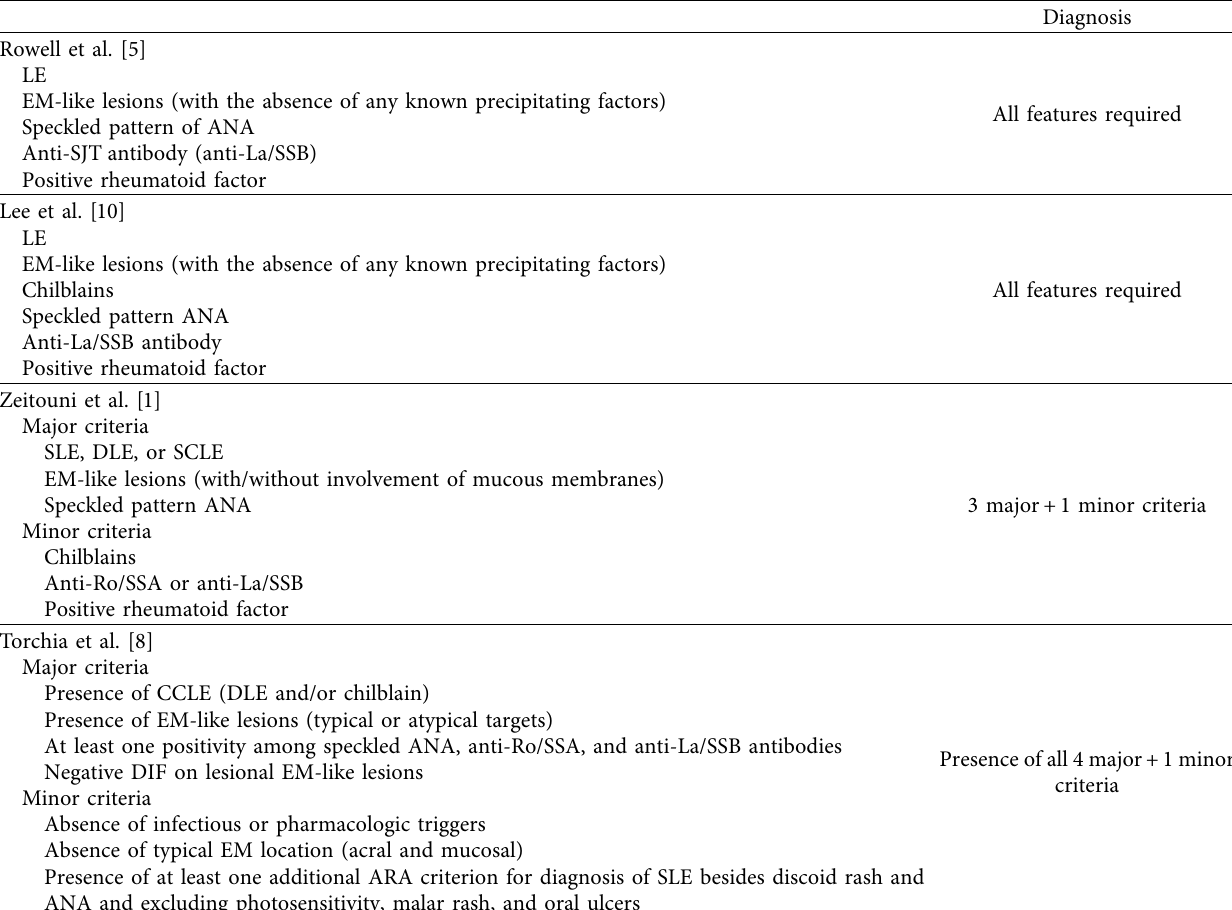
Table 1: Summary of proposed diagnostic criteria for Rowell syndrome by different